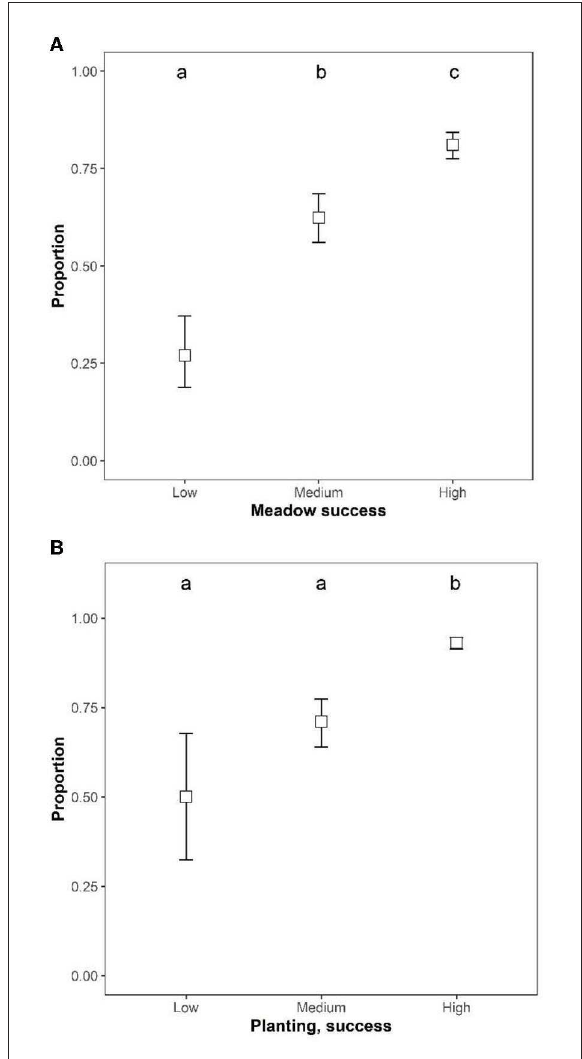
FIGURE3 The proportion of participants (estimated marginal means ± 95% confidence levels), with meadows (A) or plantings (B) that reported having seen “many insects” in relation to their perception of intervention success. Pairwise comparisons of estimated marginal means are indicated by compact letter display. Success levels sharing a letter are not significantly